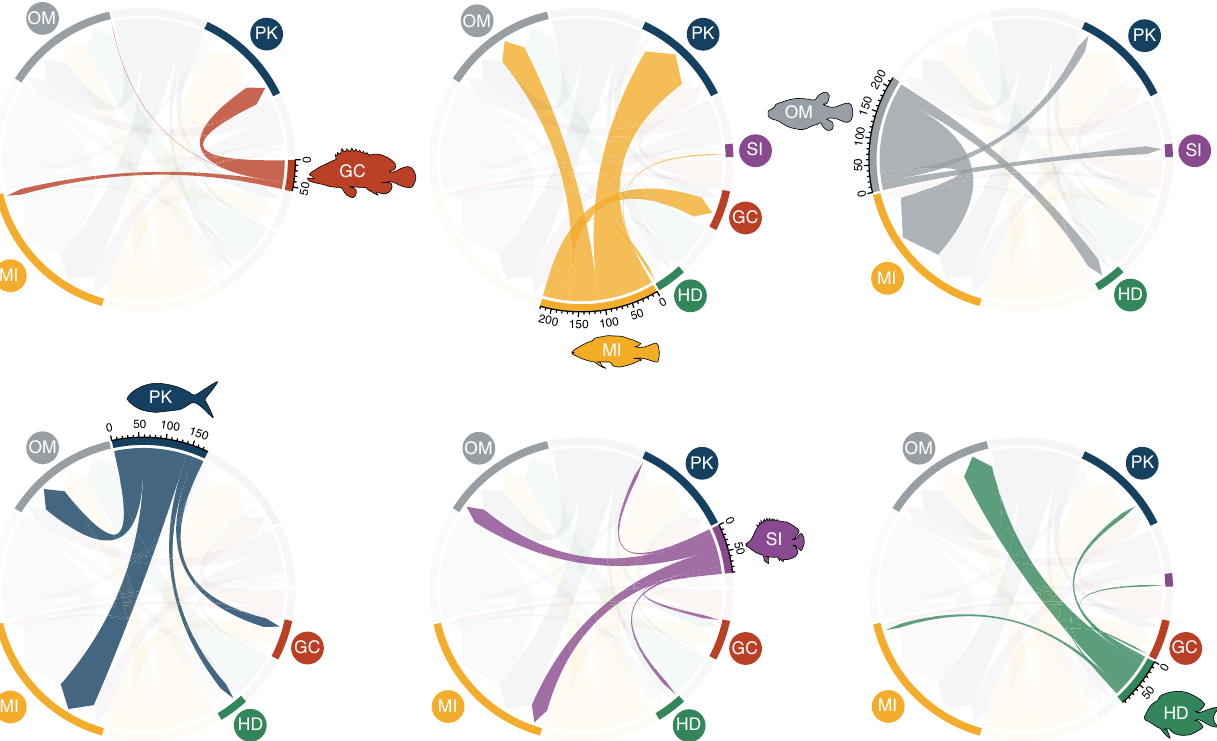
Fig. 5 Directionality of transitions out of each reef fi sh trophic group. Maximum chord width represents the number of lineages averaged between 100 trees, shown in the scale. HD: herbivores/detritivores (green); SI: sessile invertivores (purple); OM: omnivores (gray); PK: planktivores (blue); MI: mobile invertivores (yellow); GC: generalized carnivores (red). Fish silhouettes were sourced from Schiettekatte et al. 91 . Source data is provided as a Source Data fi